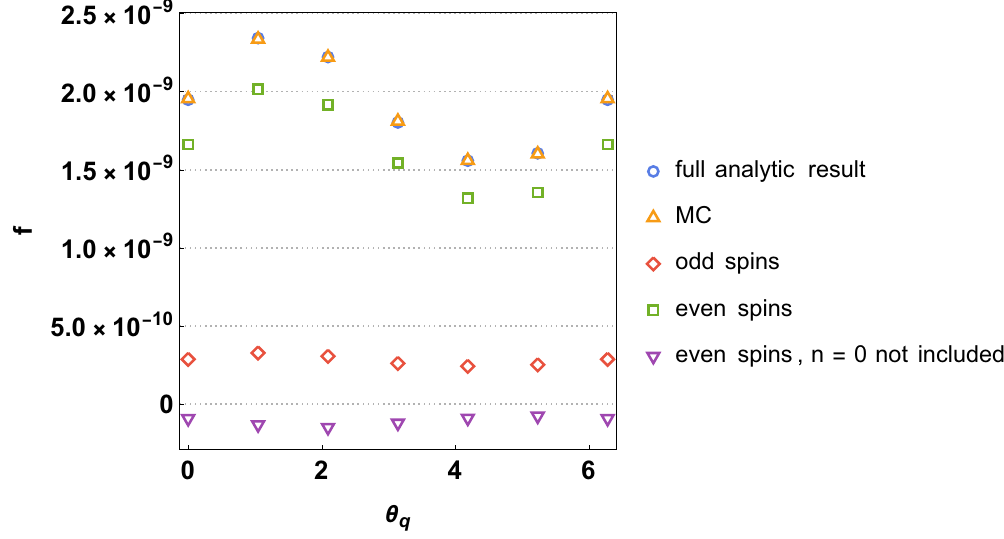
Figure 2: Gluon Green’s function dependence on θ q for fixed | ~k a | , | ~k b | , | ~q | , θ a , θ b and Y